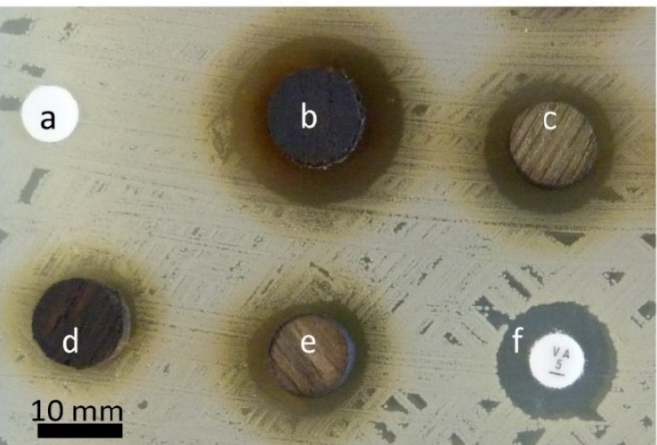
Figure 3. An antibiogram showing the results of filter paper discs (6 mm) and different oak tree wood discs (10 × 3 mm) tested against Staphylococcus aureus ATCC 29213 inoculated on a Mueller–Hinton agar plate: ( a ) negative control inert filter paper disc; ( b ) oak wood transversal cut; ( c, d , and e ) oak wood longitudinal cut, and ( f ) positive control antibiotic (Vancomycin (Oxoid, Basingstoke, United Kingdom); © Authors.